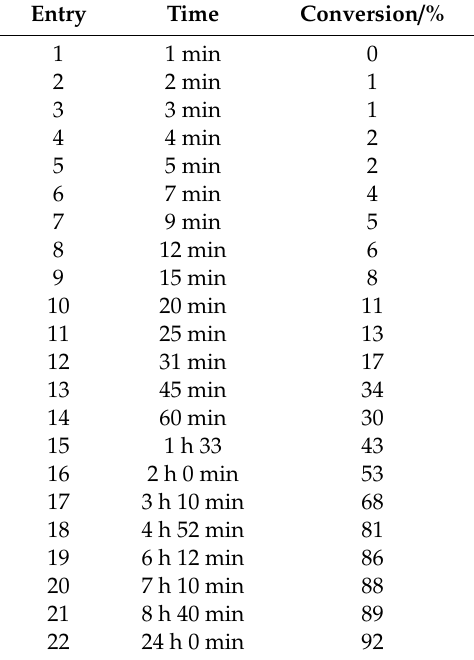
Table A12. Reduction of acetophenone ( 1 ) to 1-phenylethanol ( R )- 2. Change from standard procedure: superabsorber (100 mg), LB-ADH (46.9 µ L), GDH (159.5 µ L), NADPH (100 µ L), glucose (1.5 mL), MTBE (3 mL), acetophenone (58.3 µ